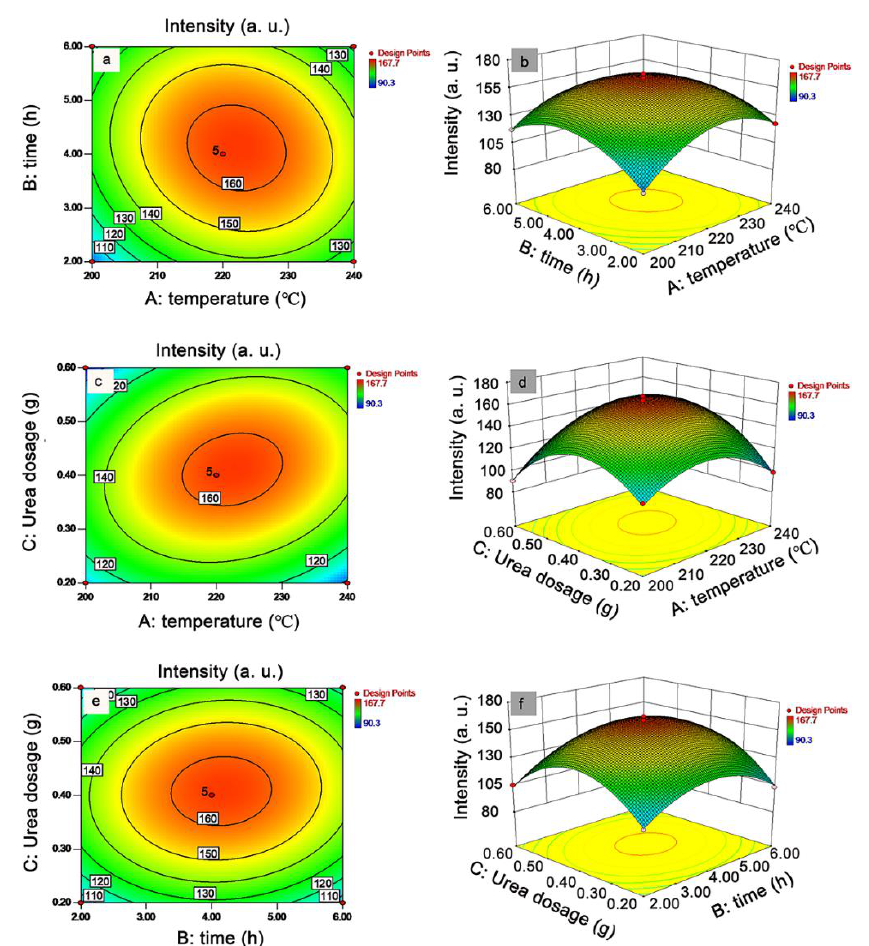
Figure 2. Contour plot and 3D response surface between each factor (A = temperature, B = time, C = urea dosage) and the intensity at 417 nm of the N-CQD solutions: contour plot and 3D response surface between A and B ( a , b ), A and C ( c , d ), B and C ( e , f ). The optimal solutions obtained by the Design Expert software were: temperature = 217.75 ◦ C, time = 4.17 h, and urea dosage = 0.40 g. Considering the actual operation effects, the conditions were adjusted as temperature = 220 ◦ C, time = 4 h, and urea dosage = 0.4 g. Replication experiments of N-CQD preparation were performed by using the adjusted conditions three times (Table 6). The average intensity of the three times of replication experiments was 162.5, while the predictive intensity of the model was 163.7. The error of the actual and predictive intensity was calculated as 0.73%. Such a slight error indicated that the model was reliable in intensity predicting. Notably, the N-CQD-13 was prepared by these adjusted optimal conditions (Table 4). Hence, N-CQD-13 was selected as the optimized N-CQD in the following